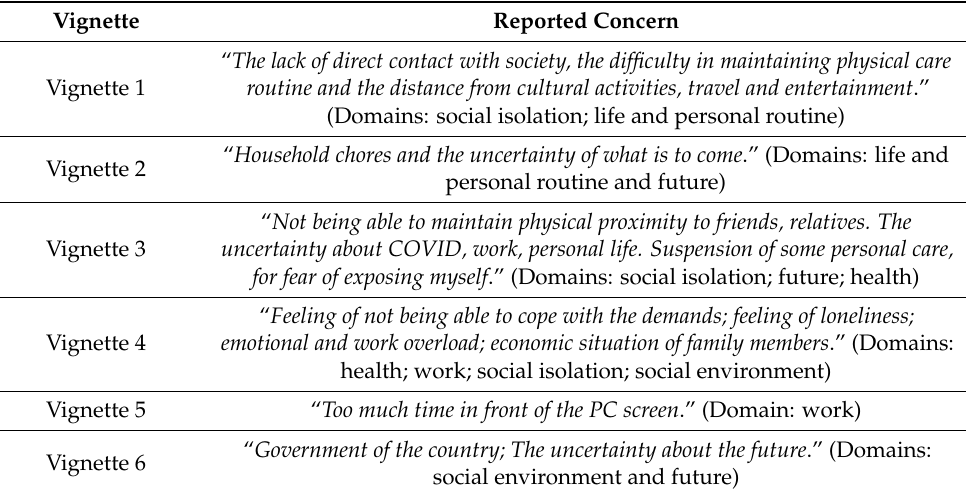
Table 2. Concerns of participants who deteriorated during the 3 months of social